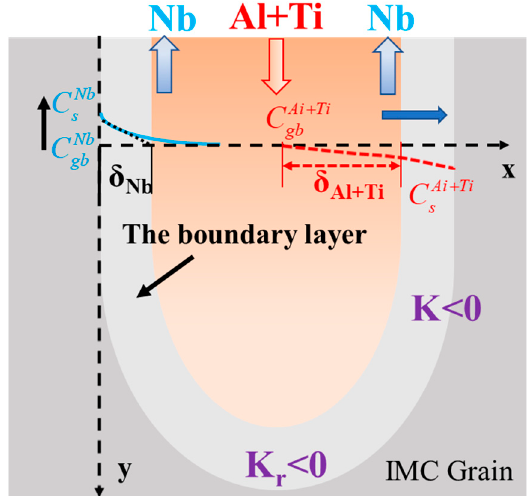
Figure 6. Illustration of diffusion of Al, Ti and Nb atoms along the U-type GB in the solid IMC phase for steady-state dissolution controlled by diffusion. The diffusion concentration in the GB has a subscript gb, and those of in surface with a subscript s and in TiAl melt with a subscript l , respectively, x: distance from solid surface. δ : effective thickness of diffusion layer.